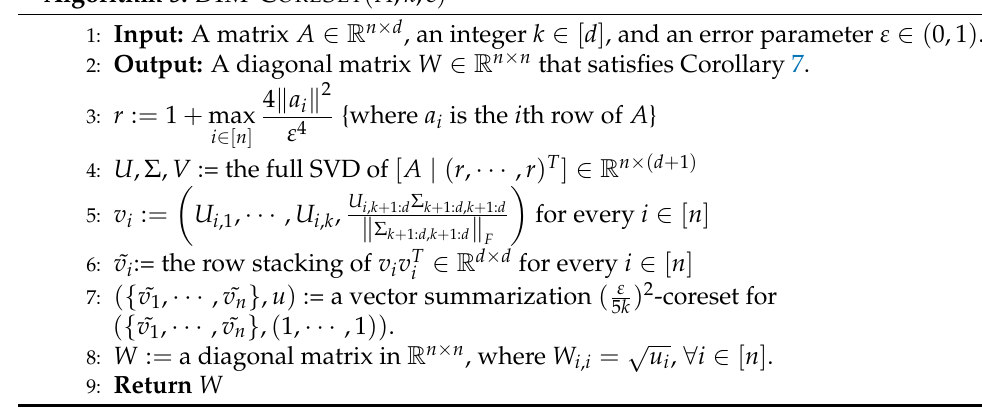
Algorithm 5: DIM-C ORE S ET ( A , k , ε